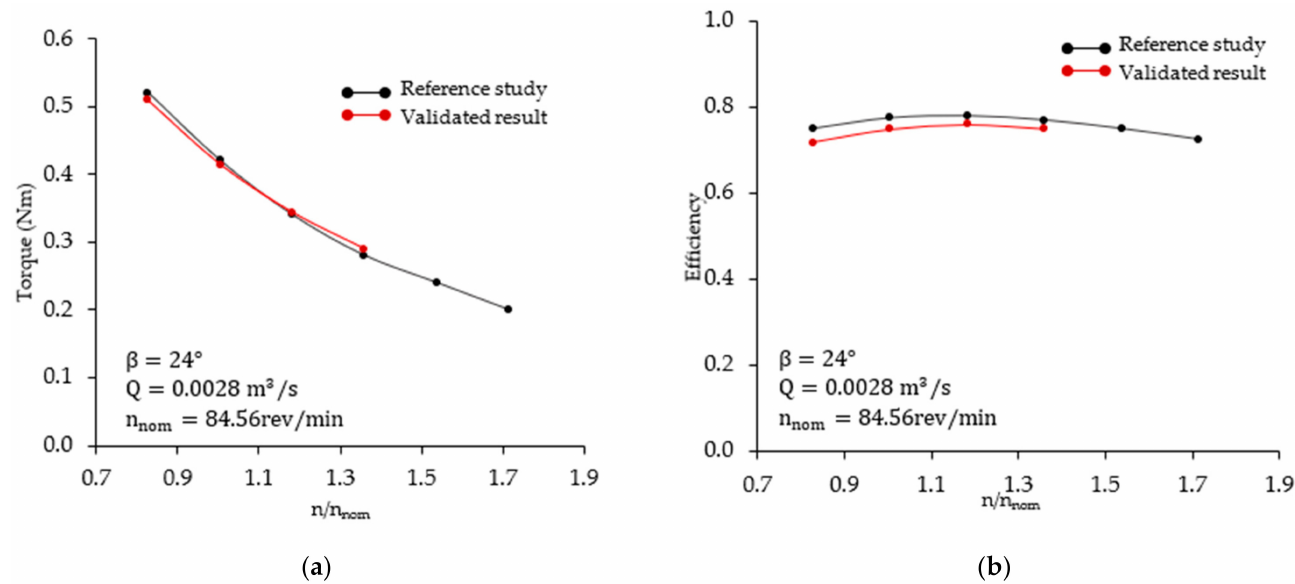
Figure 7. Comparison between re-validated AST model with reference. ( a ) Torque variation ( b ) Efficiency